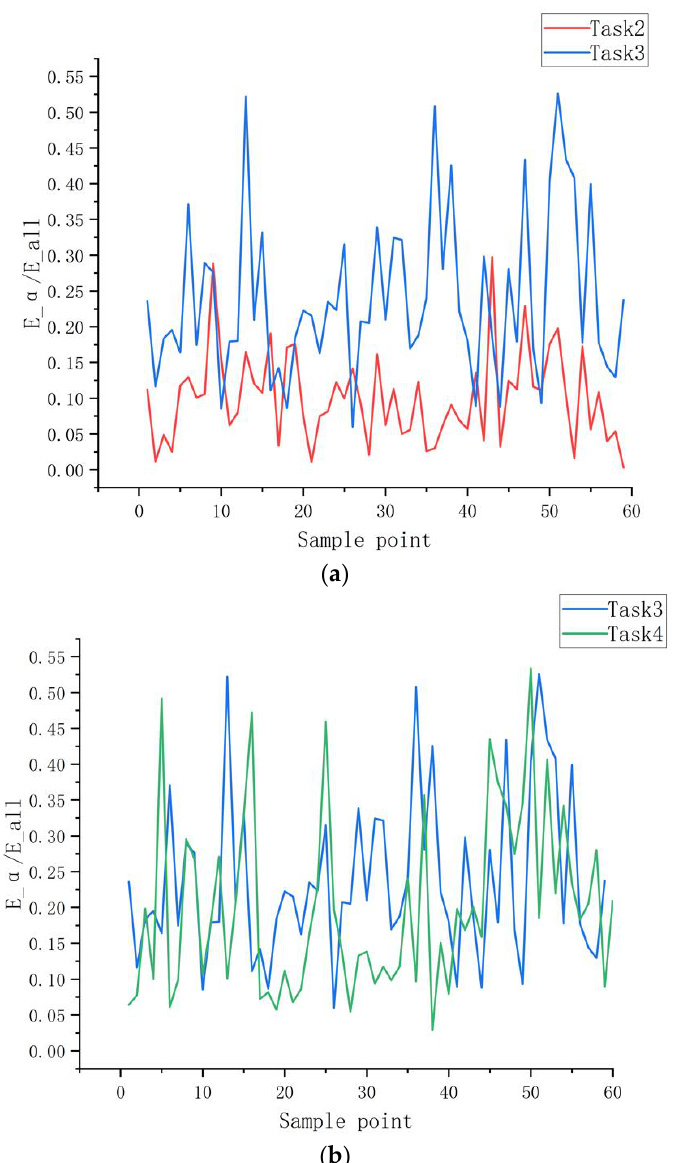
Figure 10. ( a ) E_ α /E_all is significantly lower in medium attention task compared to low attention task. ( b ) Insignificant change in E_ α /E_all in Low attention task vs. Non-externally directed task.